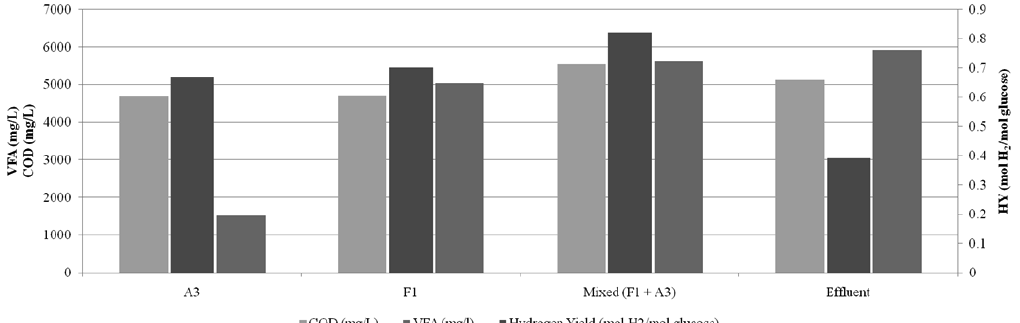
Fig. 2. The maximum results of Hydrogen Yield, COD and VFA in 90 % of Biscuit industry wastewater at pH 6.5 during the optimization